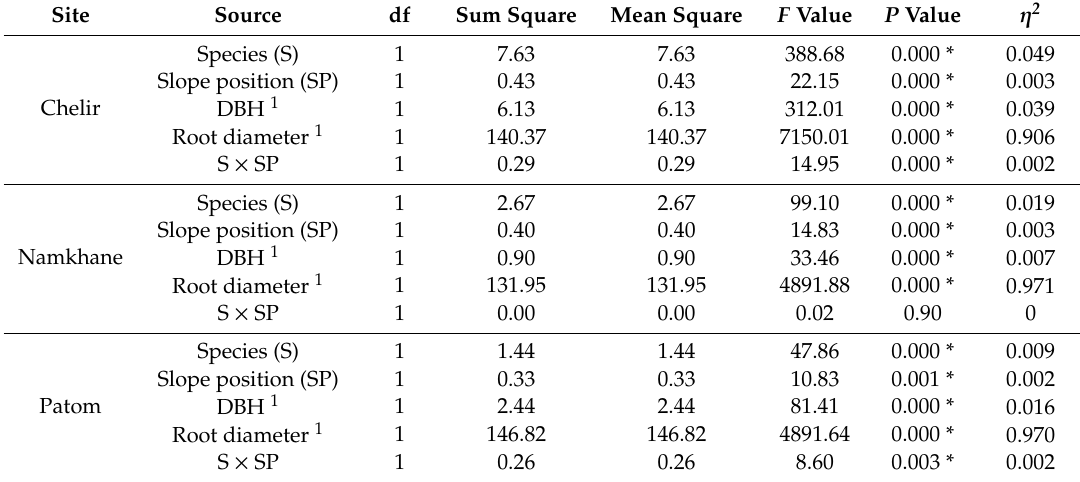
Table 3. Summary of ANCOVA results for each site, showing the e ff ect of species, slope position, diameter at breast height class (DBH), and the species x slope position interaction on tensile force (N) as a function of root